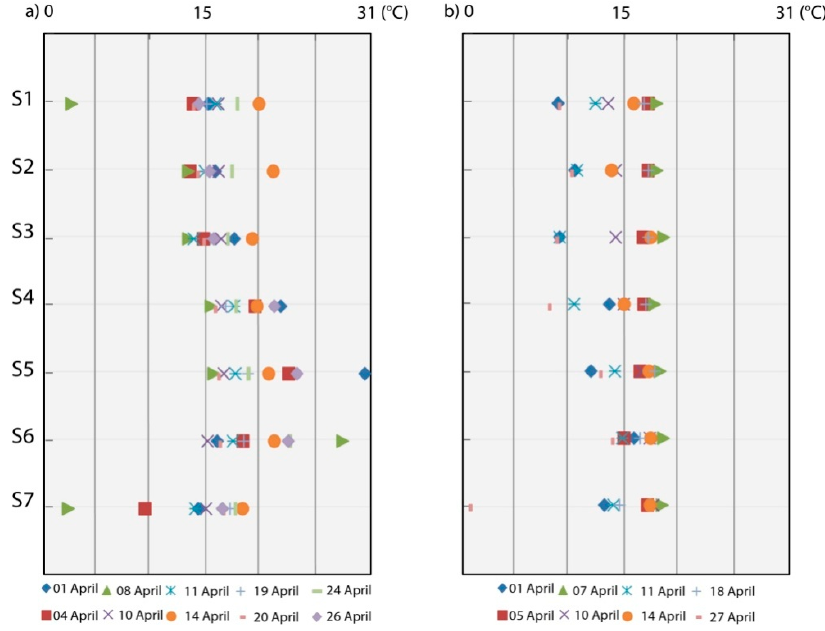
Figure 7. The variation of the water surface temperature (°C) values in the west coast of Tangier, northern Morocco, dated April 2019 ( a ) and April 2020 ( b ). The difference in average X value (X = WST − Ta; input variable in Equation (1) is shown in Figure 8. In the left image (average X value in 2019), an area where the WST values are significantly higher than the air temperature is clearly visible—the river mouth (S5) as well as Jbila beach (S4) and